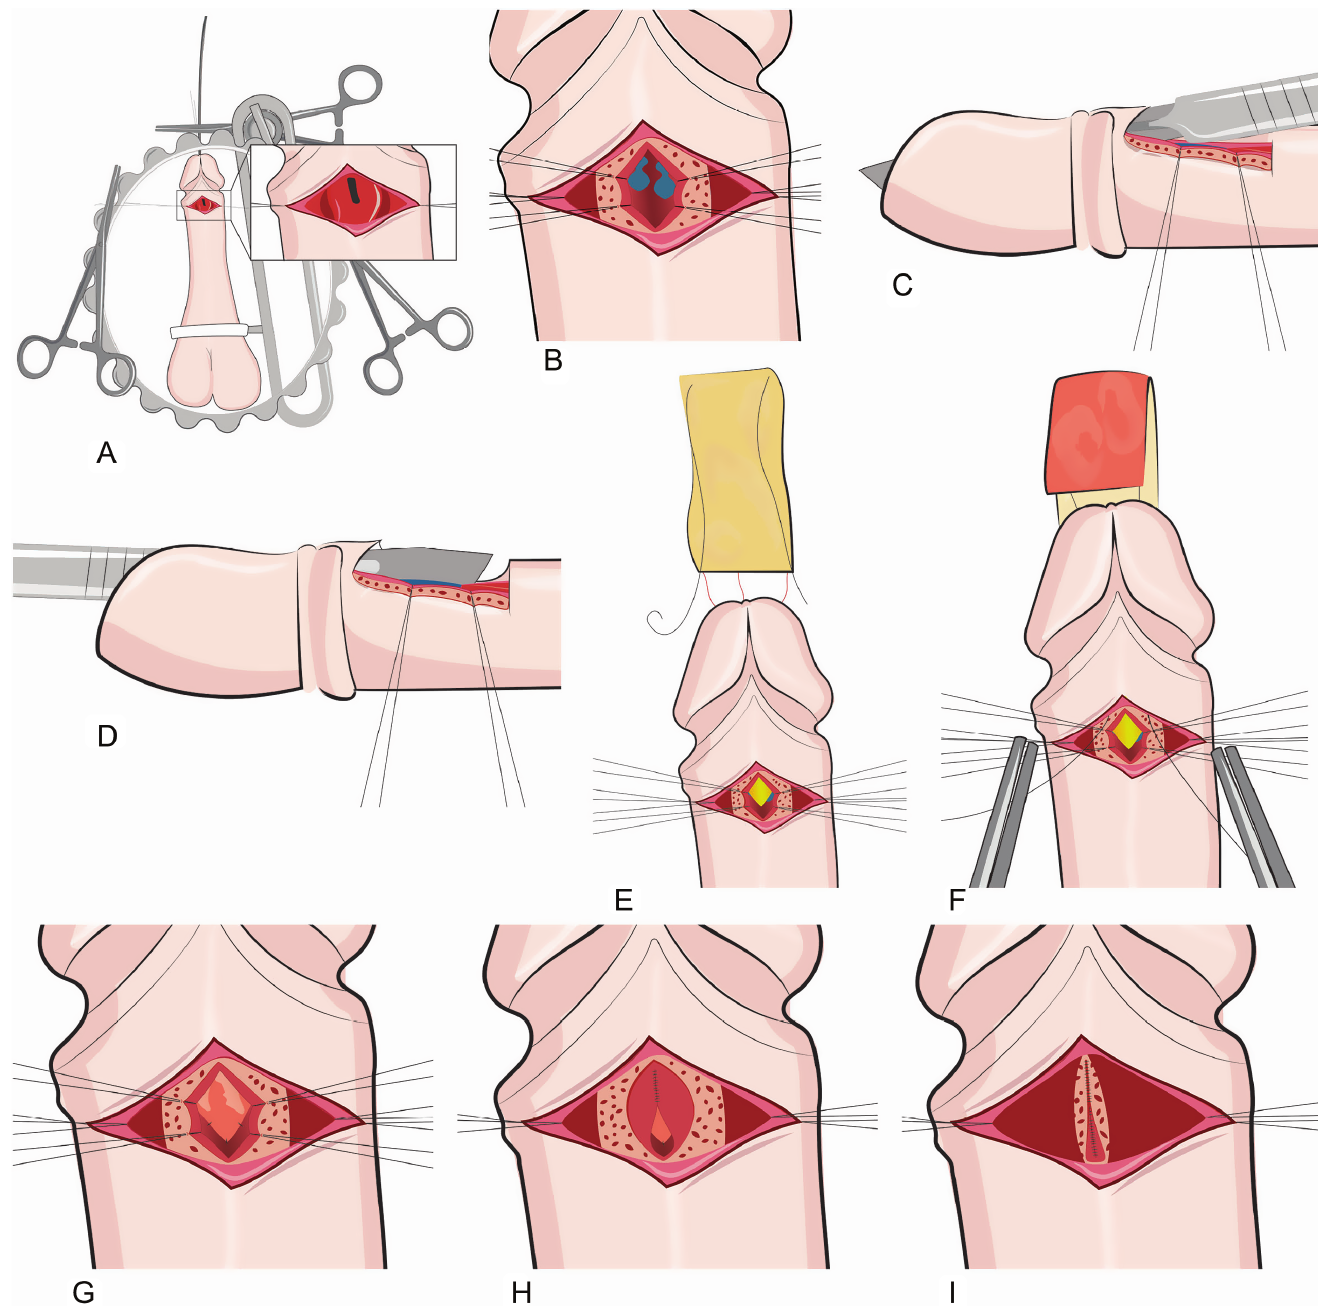
Figure 2. A schematic drawing of the key steps in the surgical process. (A) At the start, our positioning with the use of the traction suture, the Joshi-Kulkarni retractor, and the Dennis Brown ring is seen. Skin incision has been made and the probe is positioned adequately for keyhole incision in the marked urethra. The urethra is lying free from the surrounding tissue. (B) Exposed dorsal mucosal layer with a clear view of the transition from diseased to healthy tissue. Differentiation is enhanced by using methylene blue. (C and D) Dorsal urethral mucosa is incised in both directions (through the keyhole and through the meatus), starting from the transition region up to the glans penis. (E) Positioning of the graft with the mucosal side down and fixating it distally at the glans with 3 sutures. (F) Pull-through mechanism by which the mucosal side is positioned facing up conform a dorsal inlay procedure. (G) The graft is positioned adequately to cover all incised, diseased dorsal mucosa and fixated proximally onto healthy mucosa without traction on the graft. (H) Closure of the keyhole incision in the ventral mucosal layer of the urethra. (I) Closure of corpus spongiosum followed by the closing of the